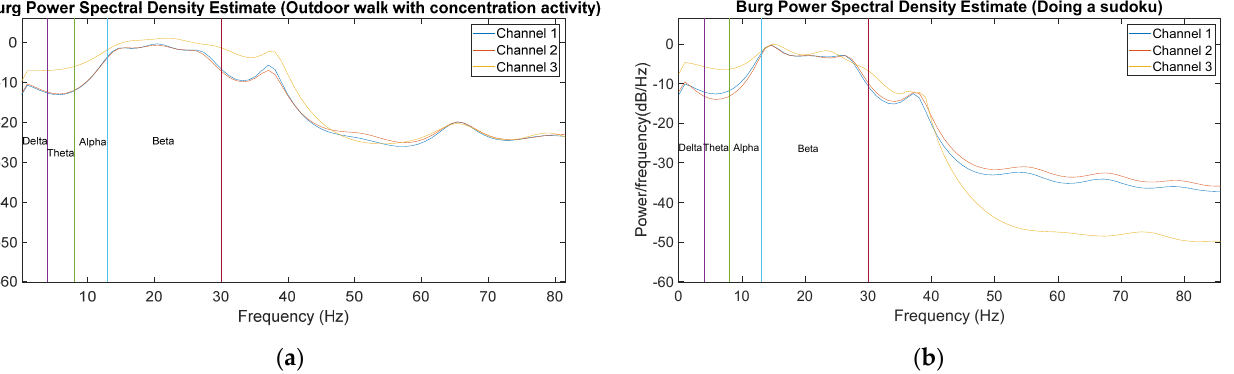
Figure 18. ( a ) Burg Power Spectral Density Estimate of the three ear EEG channels of a time window at around tenth minute (outdoor walk with concentration activity); ( b ) Burg Power Spectral Density Estimate of the three ear EEG channels of a time window at around 28th minute (doing sudoku).